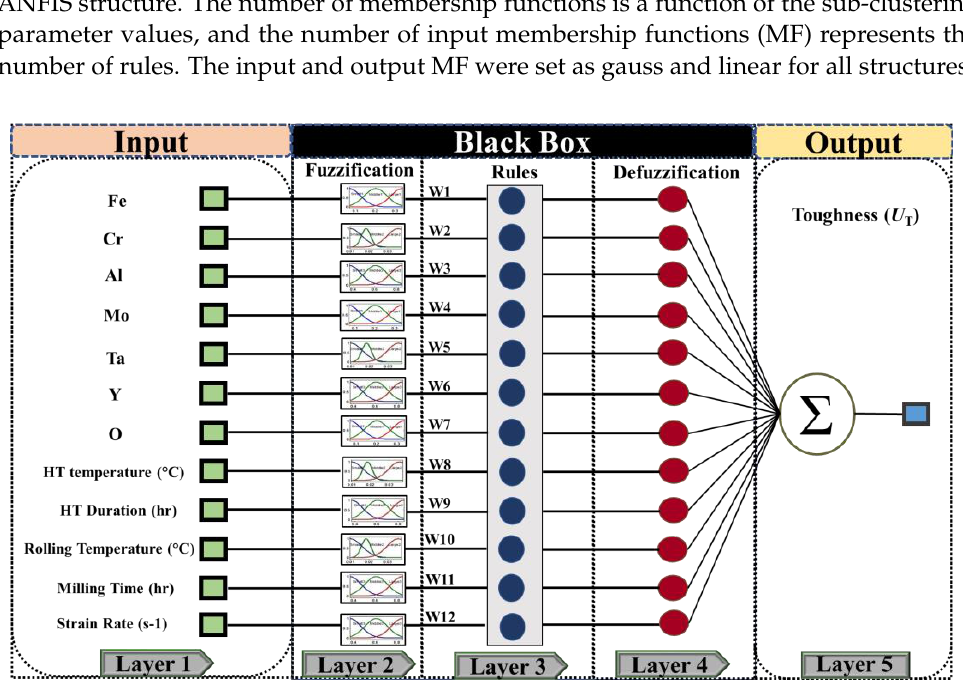
Figure 2. Typical structure for the ANN model used in this study [32].